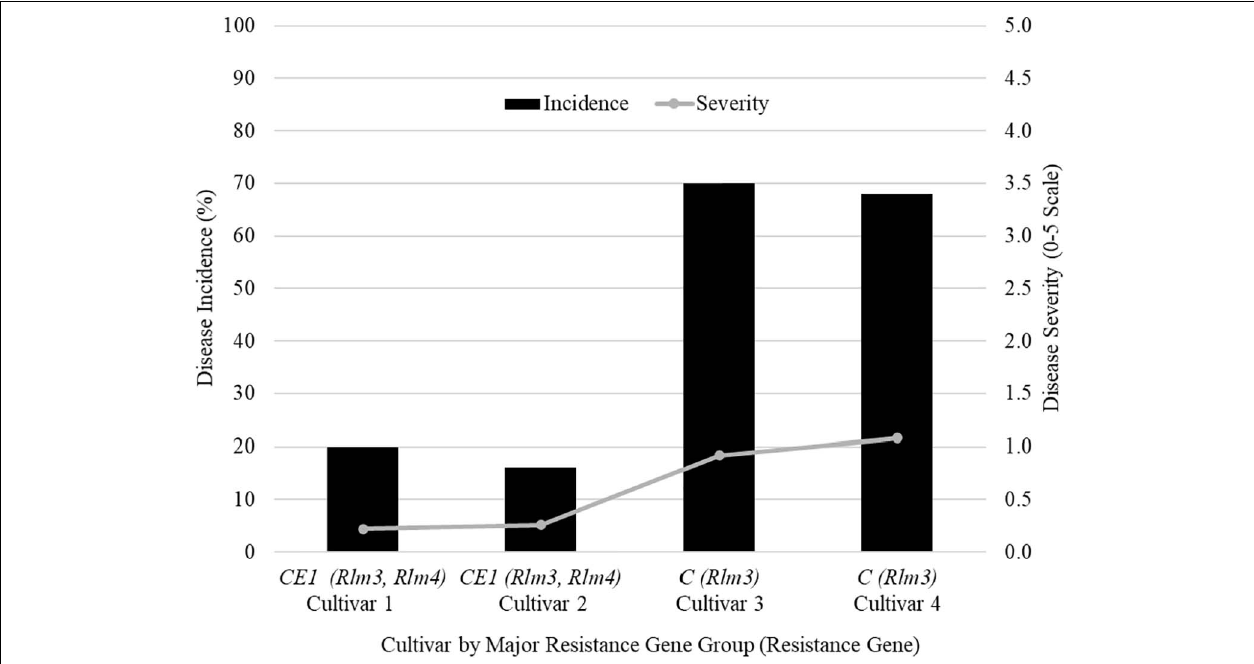
FIGURE 1 | The blackleg disease incidence and severity for field site SK1 in Saskatchewan in 2018 that had four cultivars grown to compare the effectiveness of different major resistance genes.